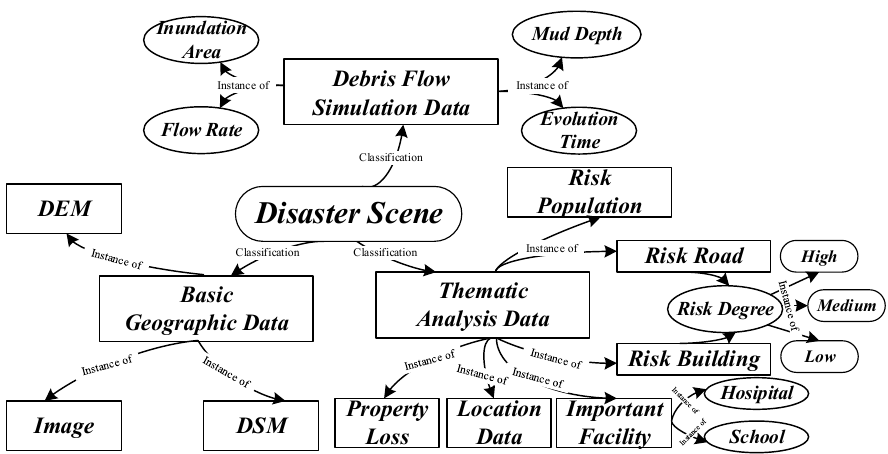
Figure 3 . Relations among debris flow disaster data sets . Figure 3. Relations among debris flow disaster data